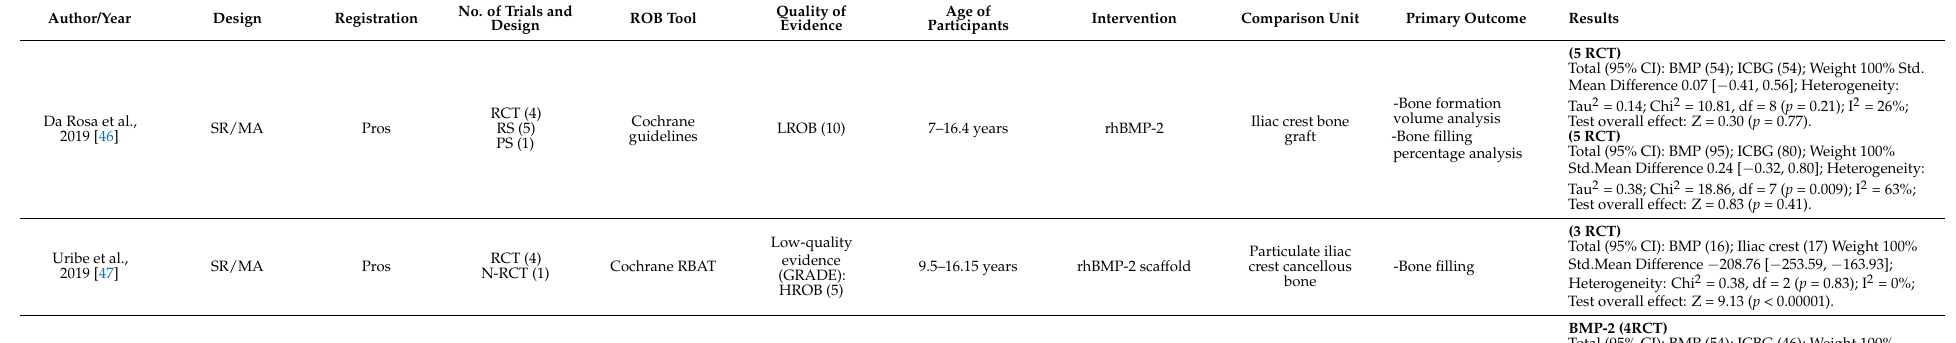
Table 2. The characteristics of the included systematic